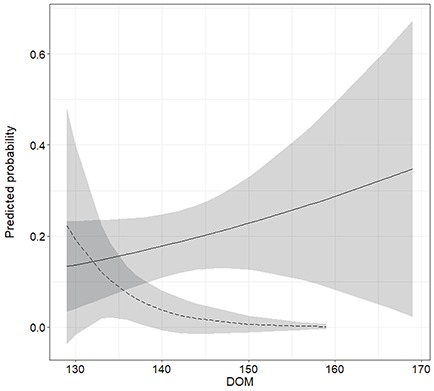
Predicted probability of an Atlantic salmon kelt returning as a consecutive spawner to Campbellton River in the summer of 2016 plotted as a function of DOM and MH (solid line: consecutive spawners, dashed line: first time spawners). Shaded area represents the 95% prediction confidence intervals.